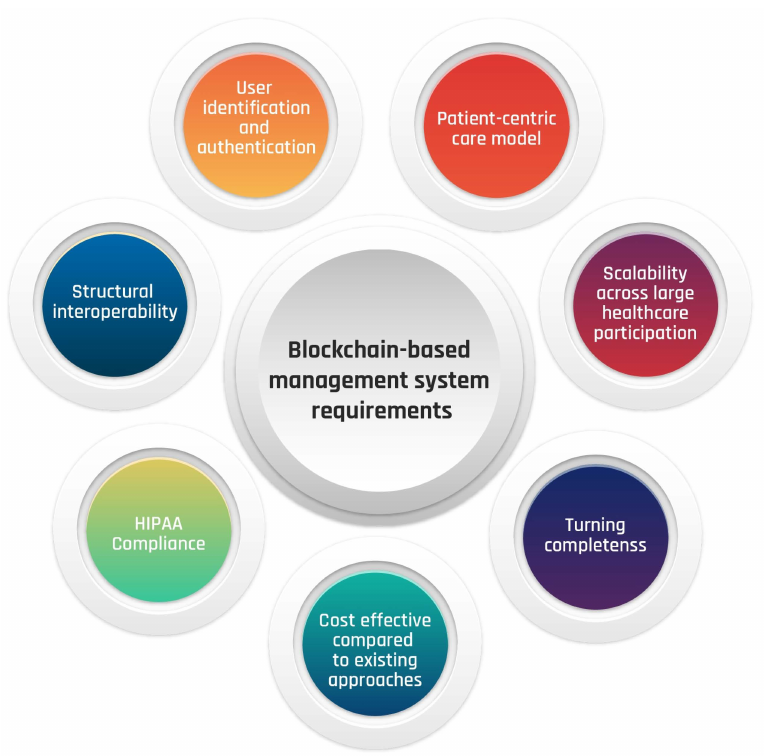
Figure 4. The seven requirements for a blockchain-based management